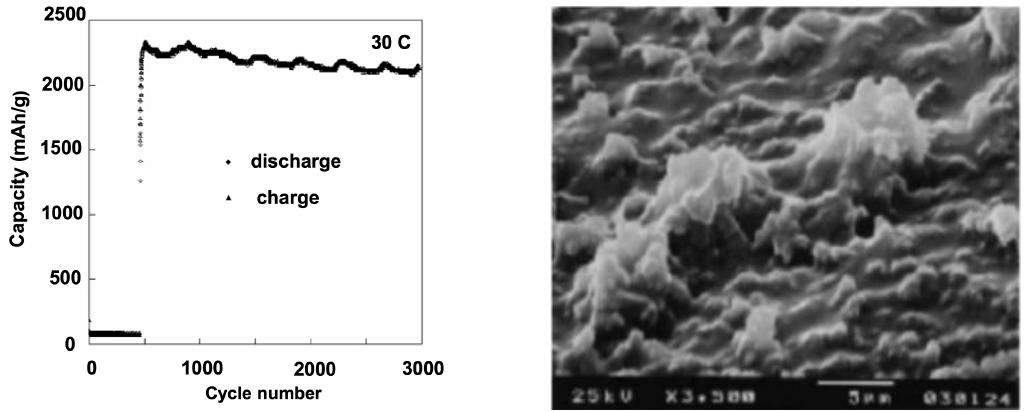
Figure 2. Capacity retention of 500 Å thick n-Si film during charge/discharge cycling with 30 C rate charge/discharge in propylene carbonate containing 1 mol·L − 1 LiClO 4 . The scanning electron microscopy (SEM) image of the Si film is shown after 1000